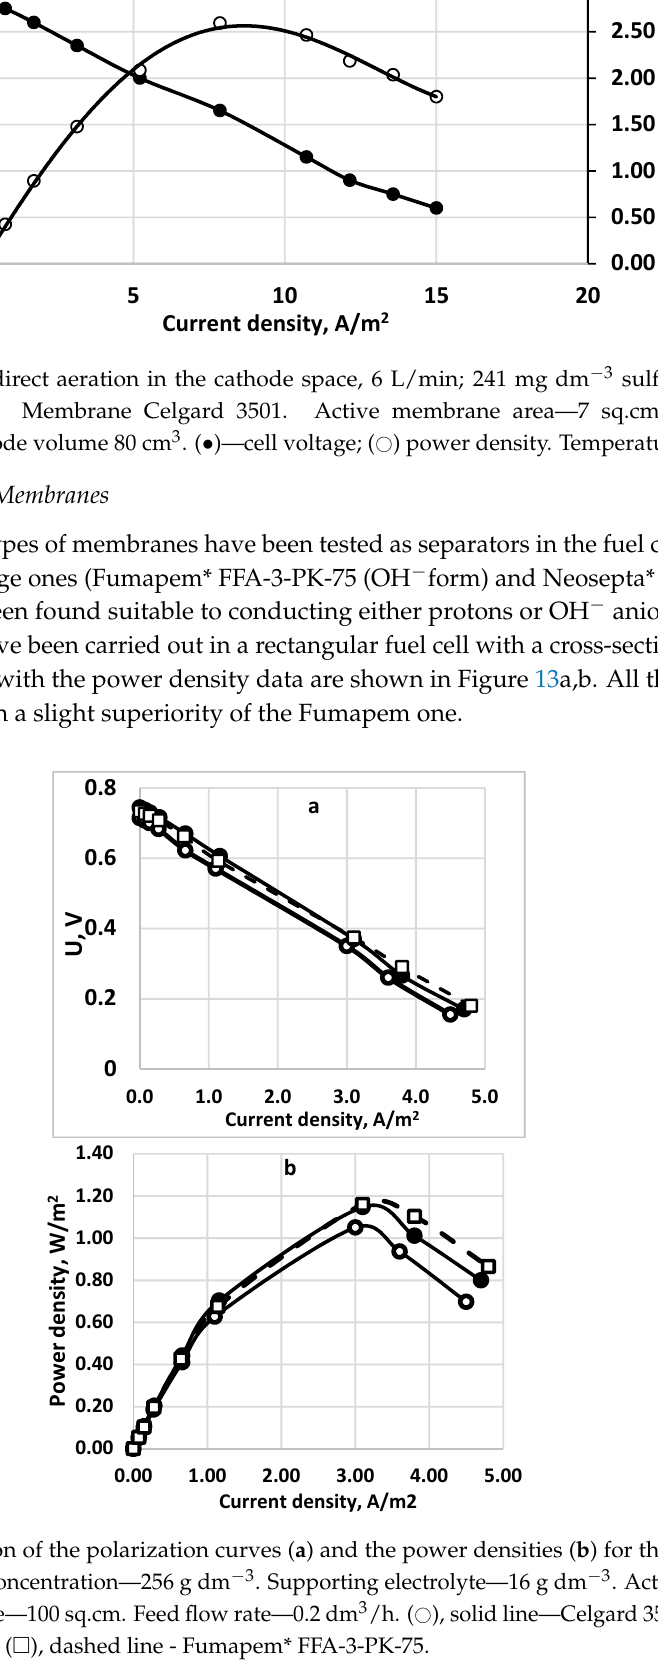
Current density, A/m 2